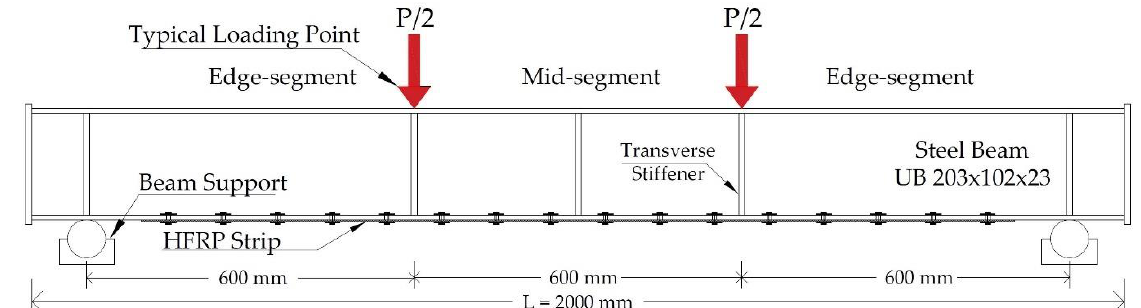
Figure 6. Simplified loading diagram of the tested beams.